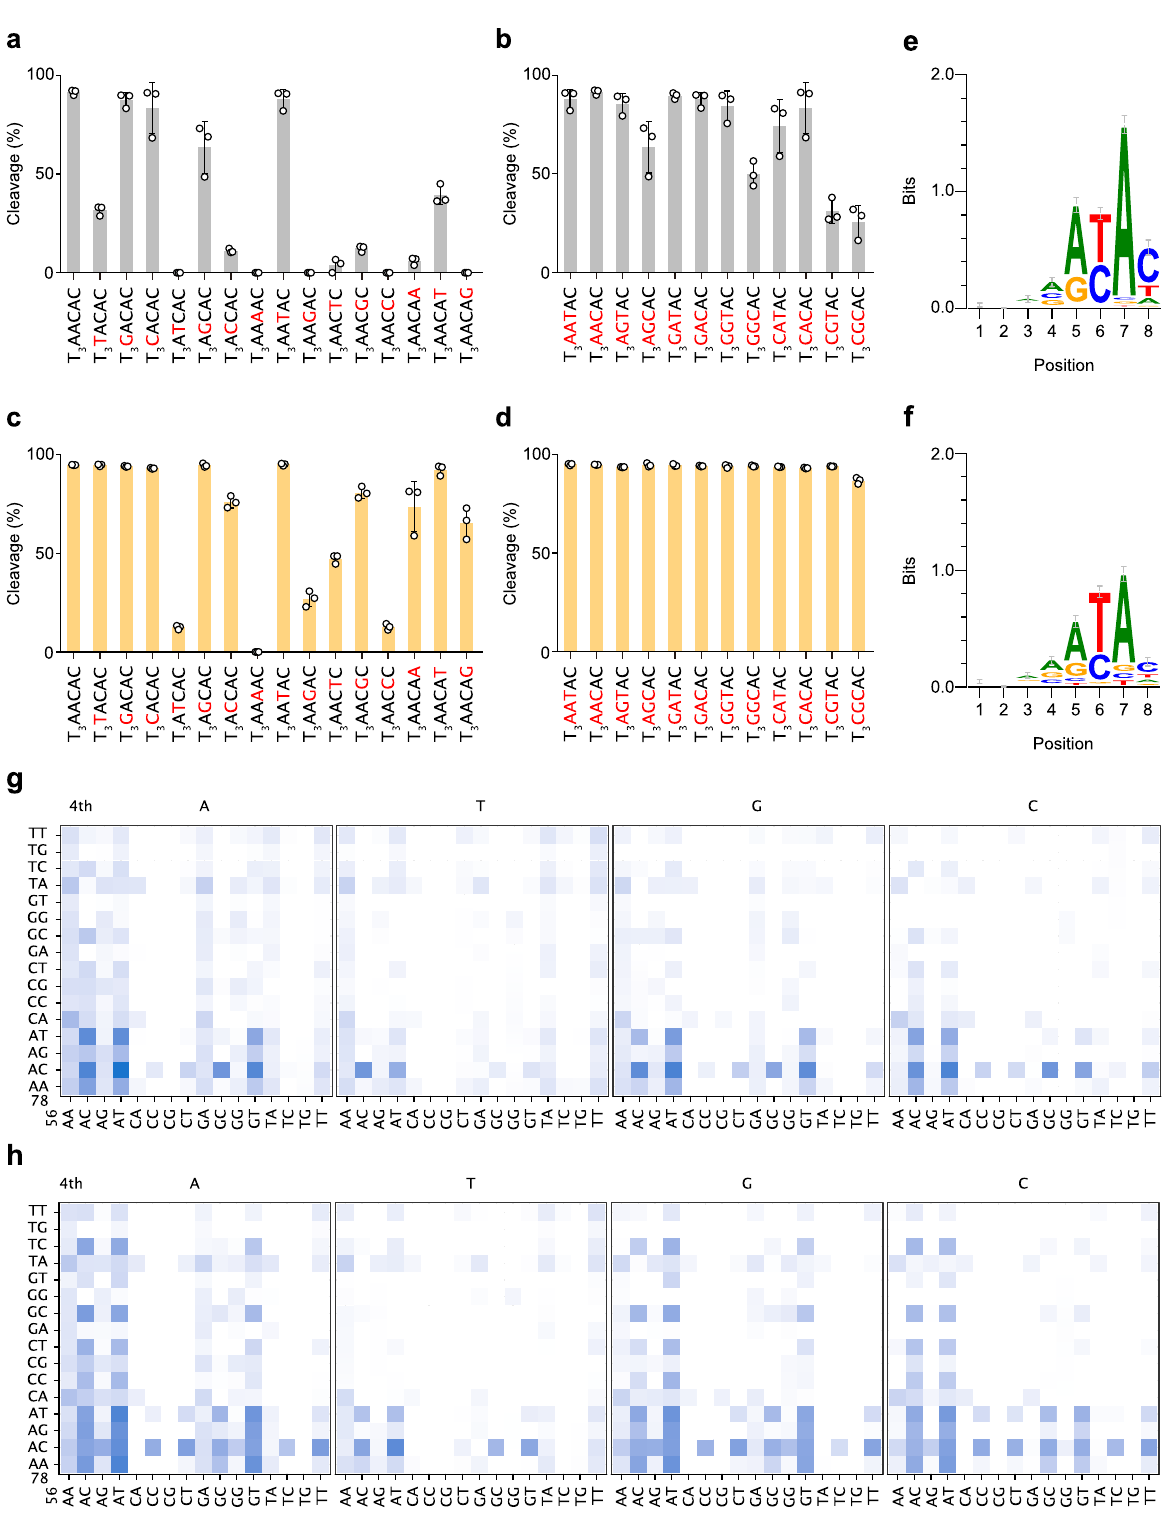
Fig. 1 In vitro cleavage activities of CjCas9 and enCjCas9. ( a – d ) In vitro cleavage activities of CjCas9 ( a , b ) and enCjCas9 ( c , d ) toward DNA targets with different PAMs. The linearized plasmid targets were incubated with the CjCas9 – sgRNA complex at 37 °C for 2 min. Data are mean ± s.d. ( n = 3). ( e , f ) Sequence logos of CjCas9 ( e ) and enCjCas9 ( f ) obtained from the in vitro PAM discovery assay. ( g , h ) 2D PAM pro fi les of CjCas9 ( g ) and enCjCas9 ( h ) obtained from the in vitro PAM discovery